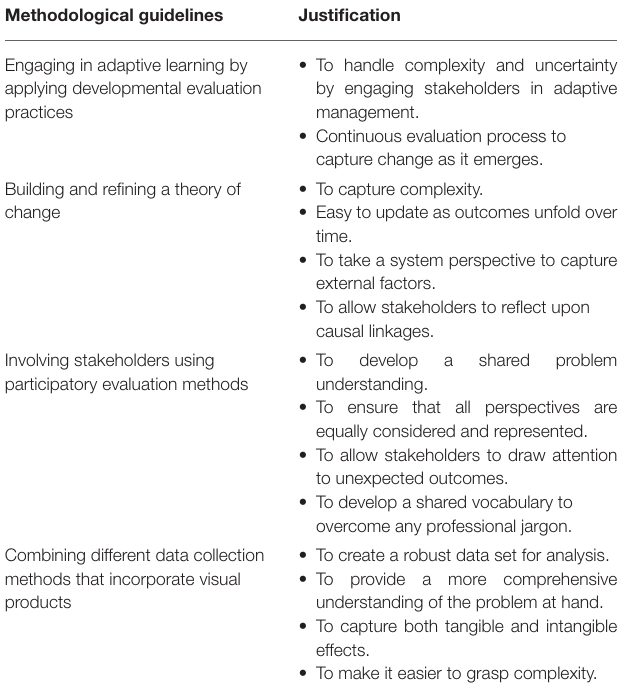
TABLE 5 | Overview of the methodological